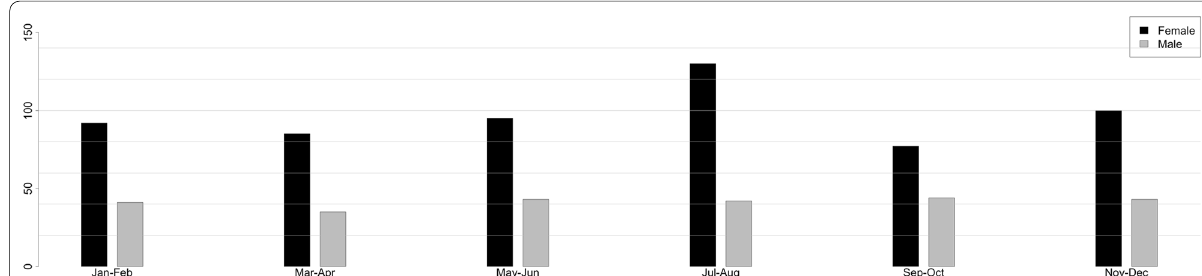
Fig. 1 Yearly distribution of DRFs in both genders according to a 2-month classification period. DRFs, distal radius fractures